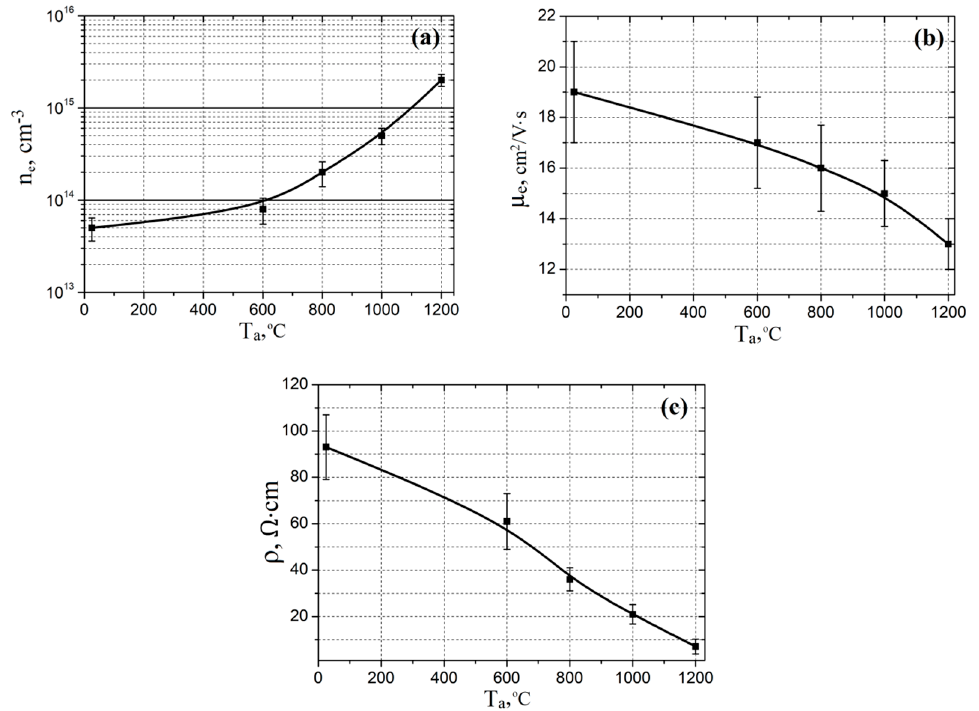
Figure 4. Experimental investigation of annealing temperature effect on electron concentration ( a ), electron mobility ( b ), and resistivity ( c ).